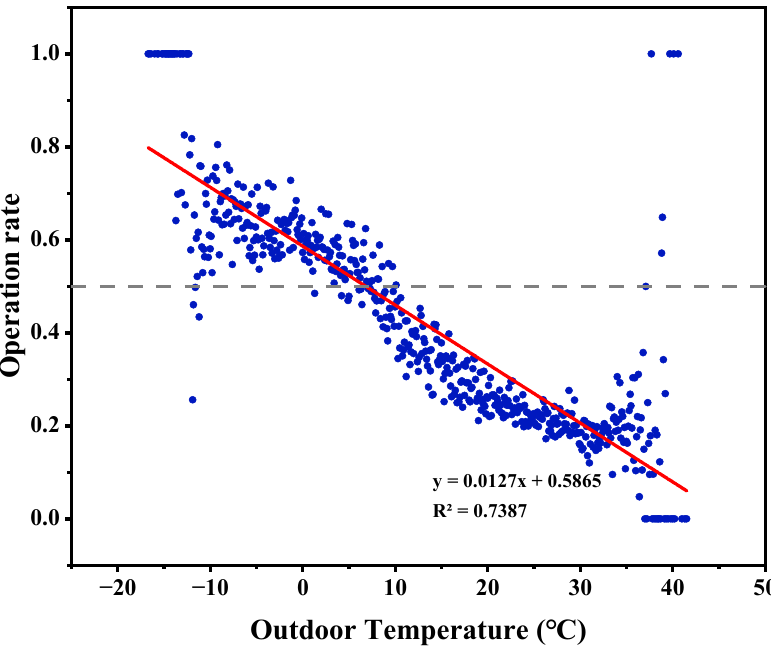
Figure 10. Relationship between mechanical ventilation system operation rate and outdoor tempera- ture in cluster 2 households.